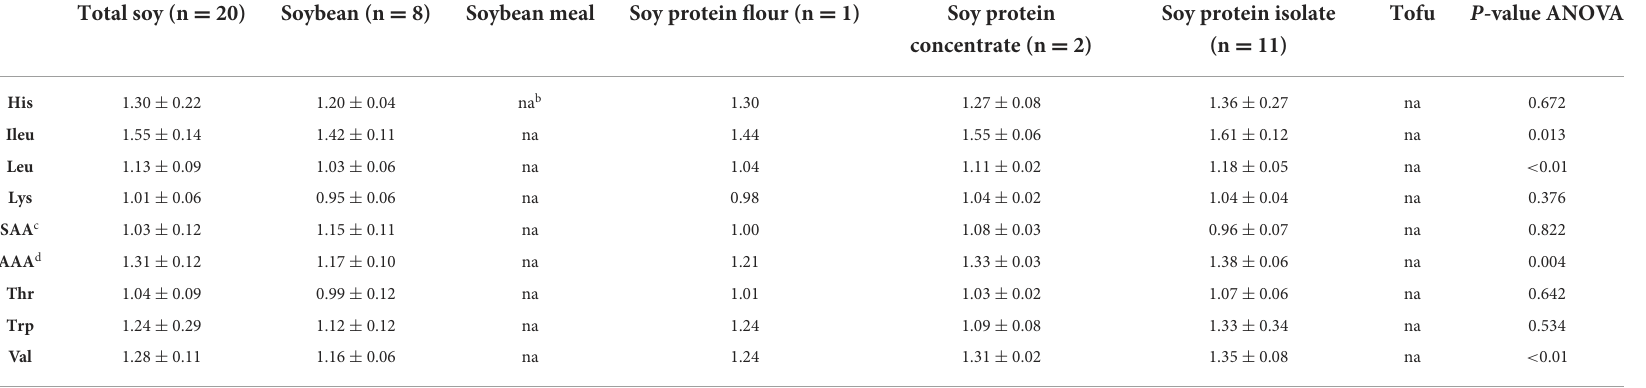
TABLE 4 Protein digestibility corrected amino acid ratios a (mean ± SD) for total soy and soy products. Total soy (n = 20)